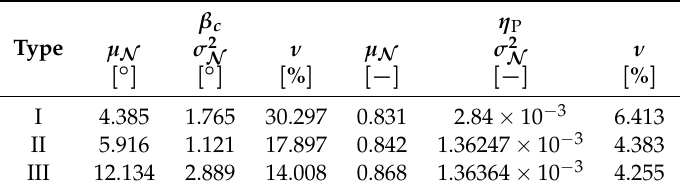
Figure 9. Illustration of ( a ) results of image processing method; histogram for each type and fit of normal probability density functions ( f N ( x ) ) for ( b ) crimp angle β c and ( c ) nesting factor η P . Table 3. Exemplary results of normal distribution fits for the crimp angel β c and the nesting factor η P (with µ N : mean value and σ 2 N :